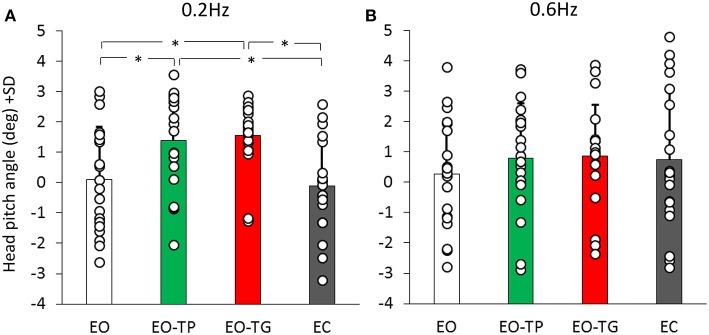
Head pitch inclination at the 0.2 Hz (A) and 0.6 Hz (B) translation frequencies (positive values mean head forward pitch). White bars refer to EO condition, green bars to EO-TP condition, red bars to EO-TG condition and gray bars to EC condition. Each white dot superimposed to the bars corresponds to the head pitch inclination of one subject. There was no difference in the head pitch inclination in the two text-reading conditions for both translation frequencies. *Indicates a significant difference.